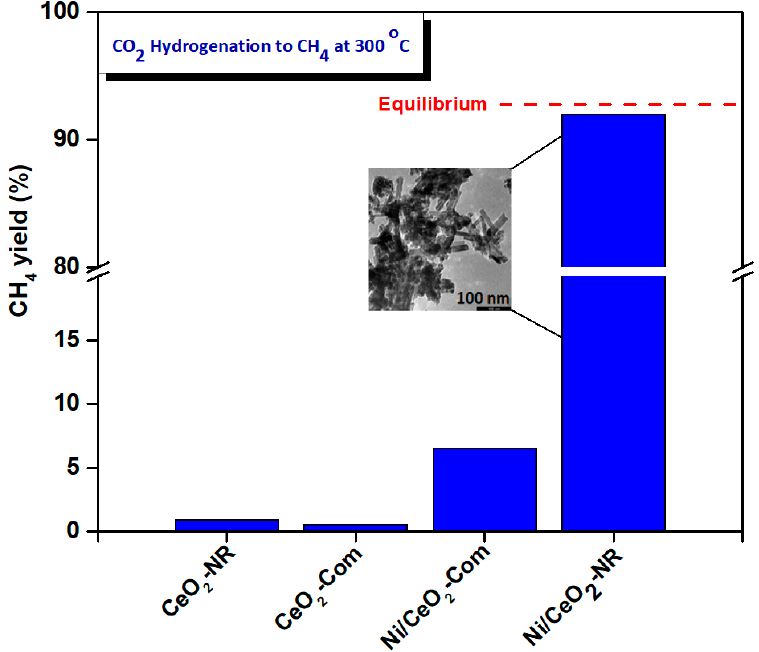
Figure 14. Methane Yield (defined as CO 2 conversion x selectivity to CH 4 ) for CeO 2 -NR, commercial ceria (CeO 2 -Com) and the corresponding Ni-based samples. Reaction conditions: Weight Hourly Space Velocity = 30,000 mL g − 1 h − 1 , H 2 :CO 2 = 4:1, P = 1 atm [39].